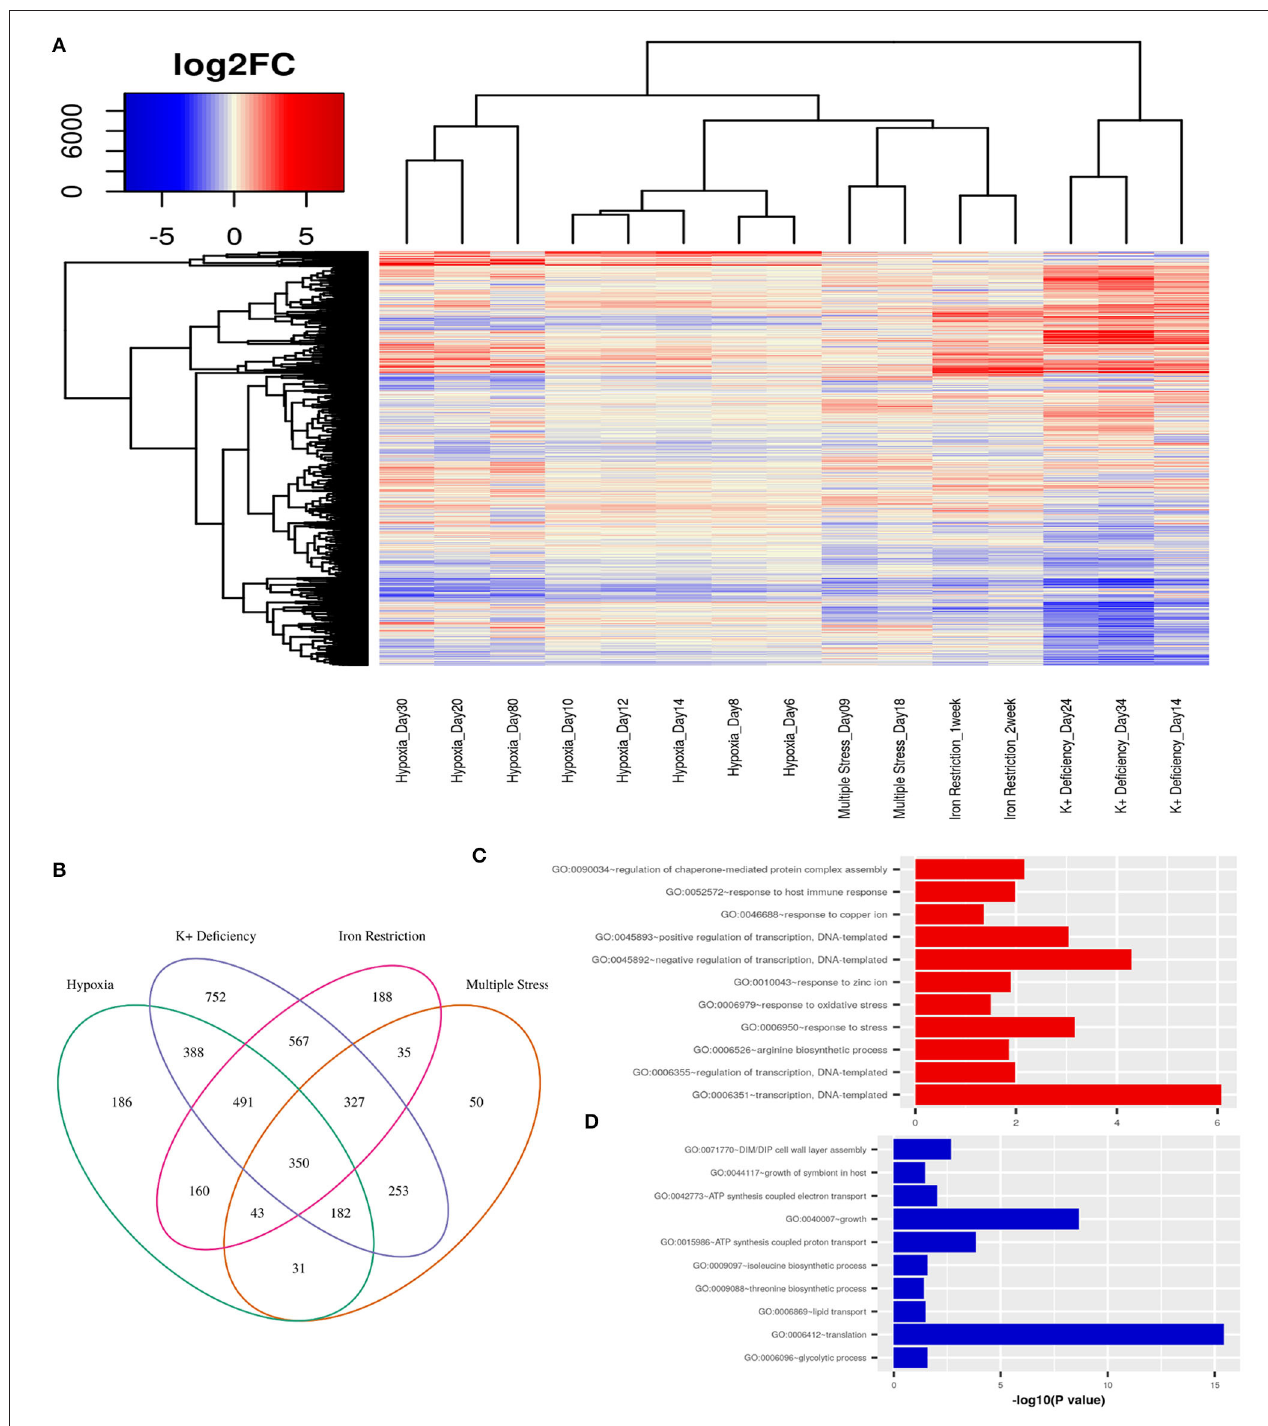
FIGURE 2 | (A) Variations in gene expression profiles of Mtb in different in-vitro dormancy models with respect to actively replicating Mtb . Gene expression alterations are depicted as log2(fold changes) over an exponential growth condition taken as the reference in each dataset. Red signifies upregulation and blue signifies downregulation of gene expression. Each column in the heatmap shows the gene expression in the time point and model indicated in the figure. (B) A Venn diagram showing the overlap between DEGs (fold change ≥ ± 1.5, FDR ≤ 0.05) between different dormancy models w.r.t. exponential growth. 350 genes were differentially regulated in all four dormancy models at some time point and 1393 genes were differentially regulated in at least 3 models. (C) GO: biological processes overrepresented in the commonly upregulated genes amongst dormancy conditions and (D) GO: biological processes overrepresented amongst the genes commonly downreguated across multiple dormancy conditions as analyzed using the enrichment tool in DAVID database (Huang et al., 2009).